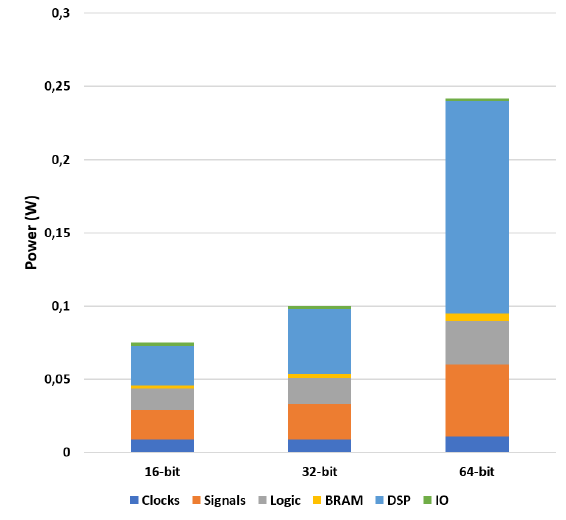
Figure 10. Power consumption of FPGA components for each bit